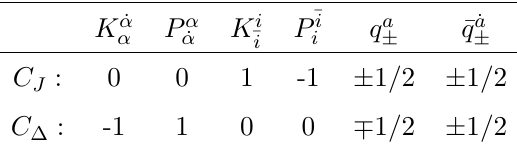
Table 1 . The charge of the generators under ∆ and J . The values of C J and C ∆ of the generators not appearing in the table are zero. Both the q ’s and the ¯ q ’s are defined in (A.4).